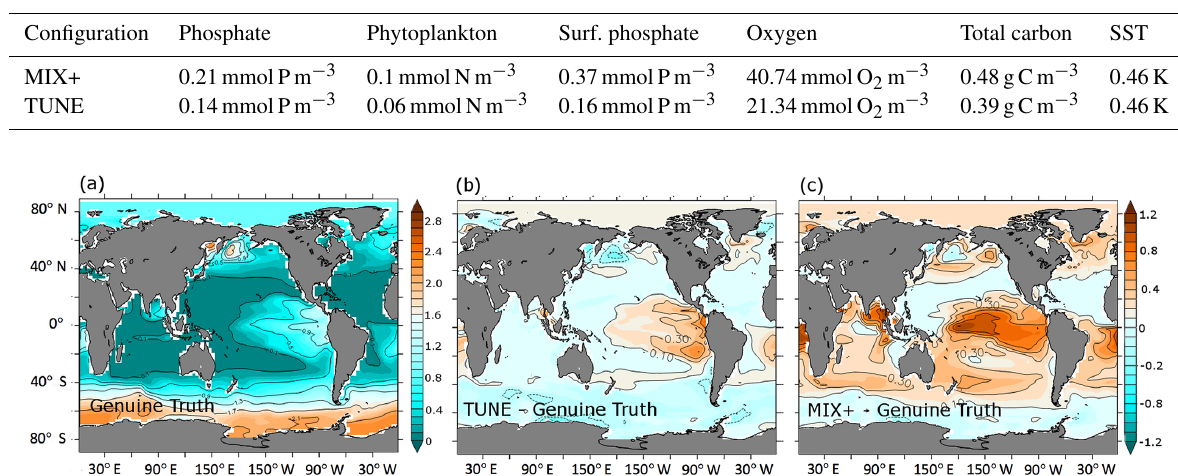
Table 3. Misfits of historical model solutions relative to the Genuine Truth calculated as the volume-weighted root mean square error (RMSE) between respective numerical experiments. Note that only phosphate and phytoplankton concentrations were used to tune the model.